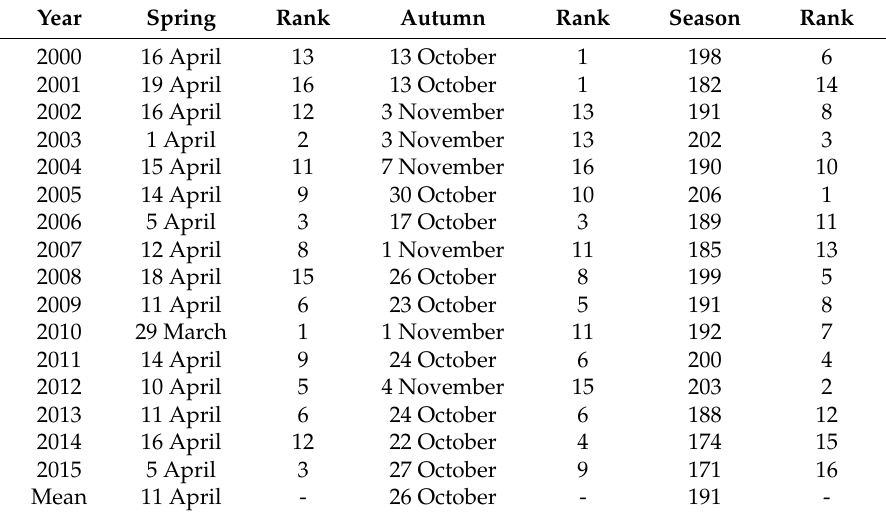
Table 1. Average gridded first and last frost dates (<0 °C) for the Park, 2000–2015. Rank indicates position out of 16 years arranged in decreasing sorted order. Season is length in days.